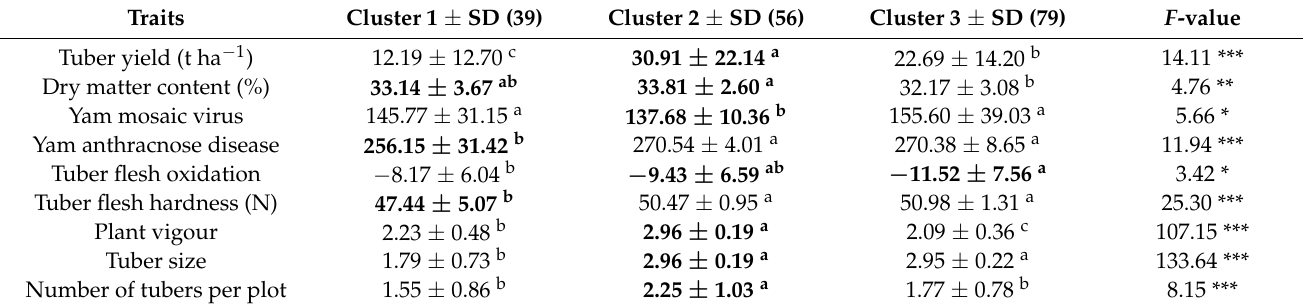
Table 5. Description of clusters of D. praehensilis and D. rotundata genotypes.